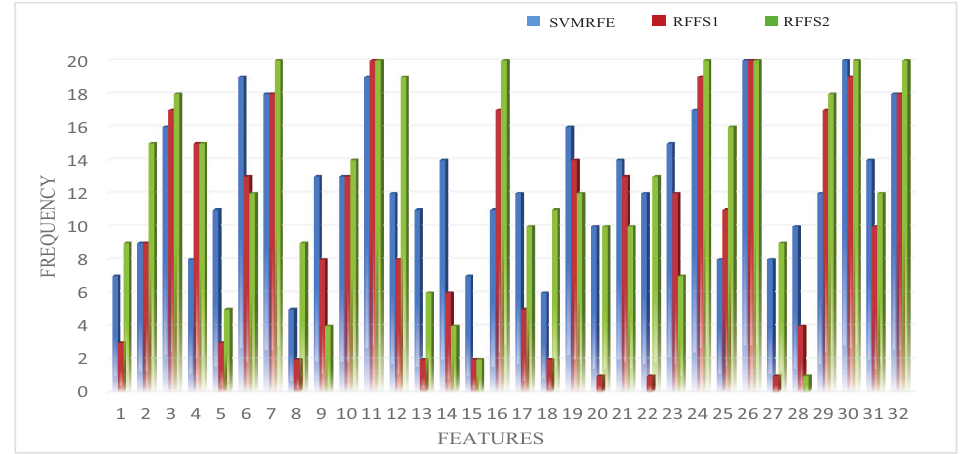
Figure 3. SVMRFE, RFFS-GI and RFFS-OOB results of SBM data.